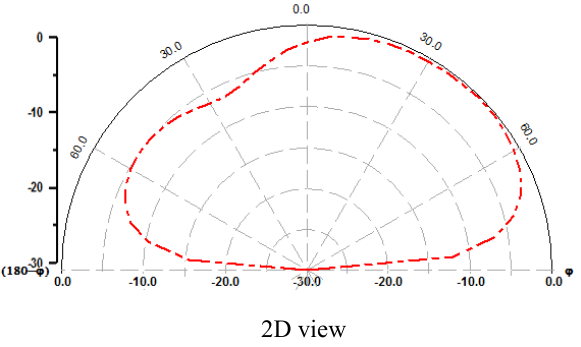
Figure 9. Return loss characteristic │S 11 │ of the suggested steerable Antenna.